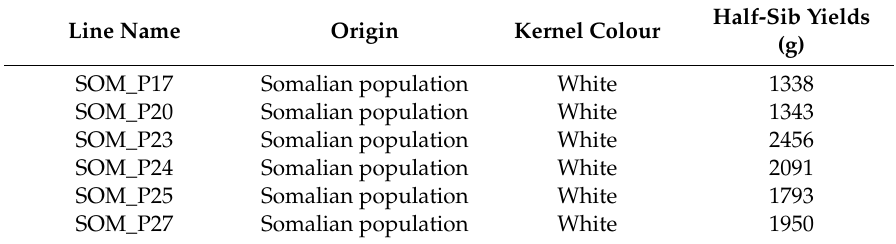
Table 1. List of the inbred lines with their relative kernel colors and the seeds produced with the open cross-pollination of the emasculated seed holder